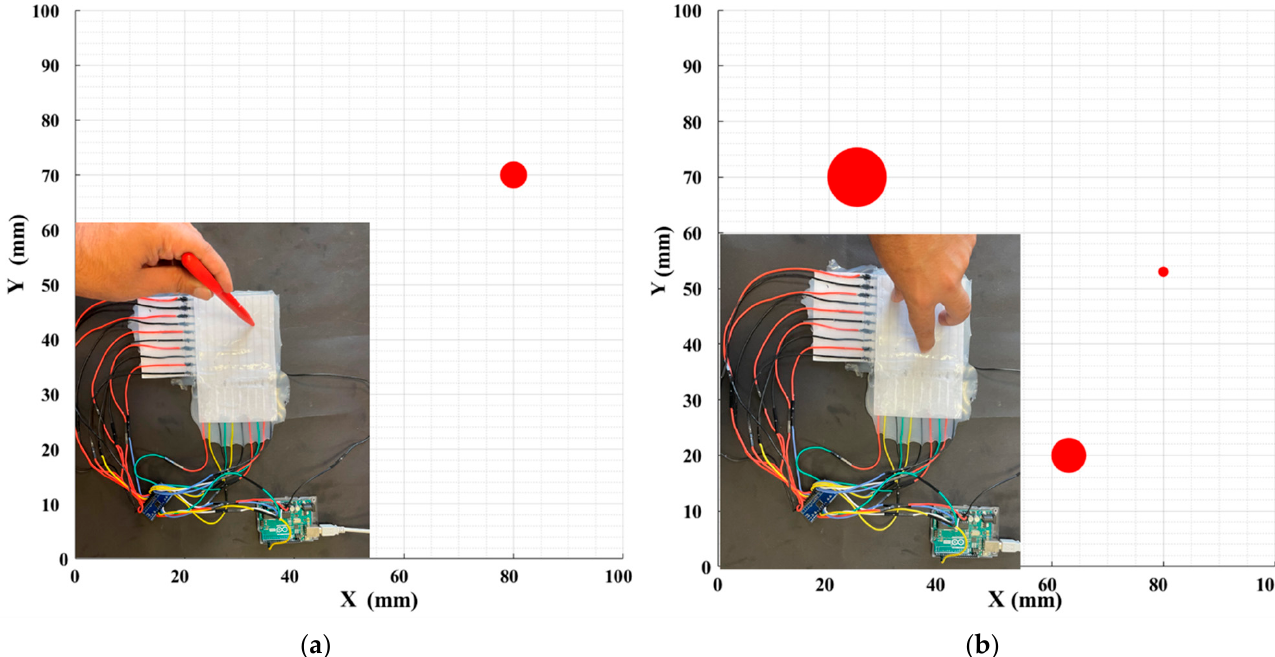
Figure 5. Multi-touch force/tactile capacitive 100 × 100 mm soft rectangular pad: ( a ) non-conductive object (plastique pen) and ( b ) conductive object (human finger) with different pressures applied.